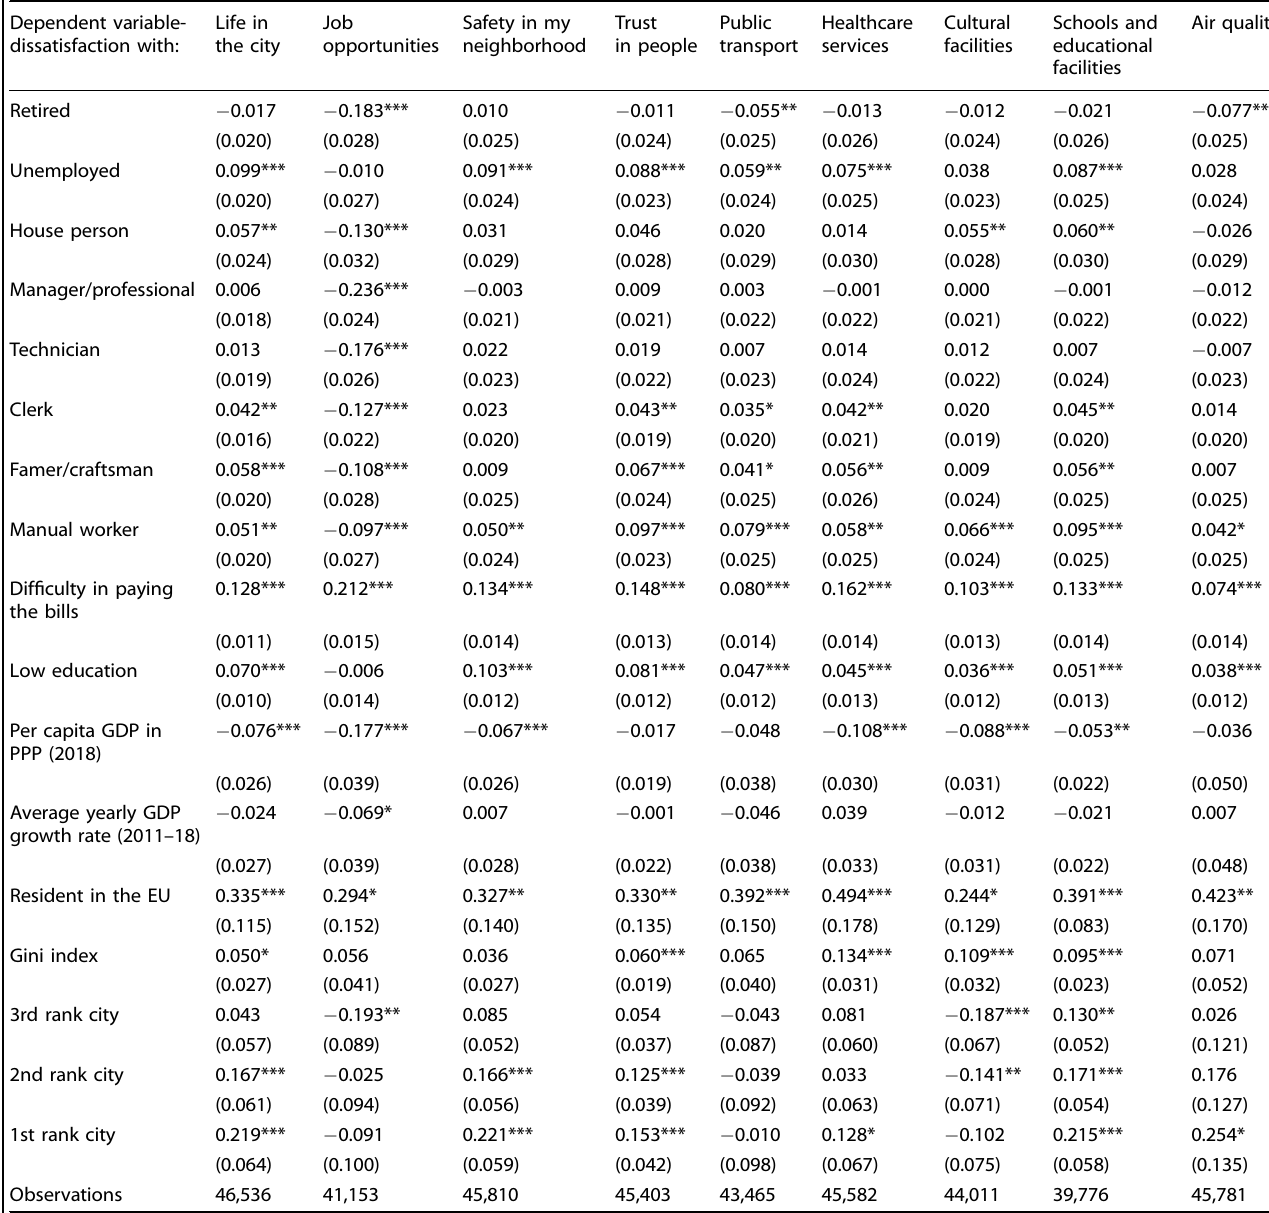
Table 3. Dissatisfaction with different aspects of urban life as a function of individual and city